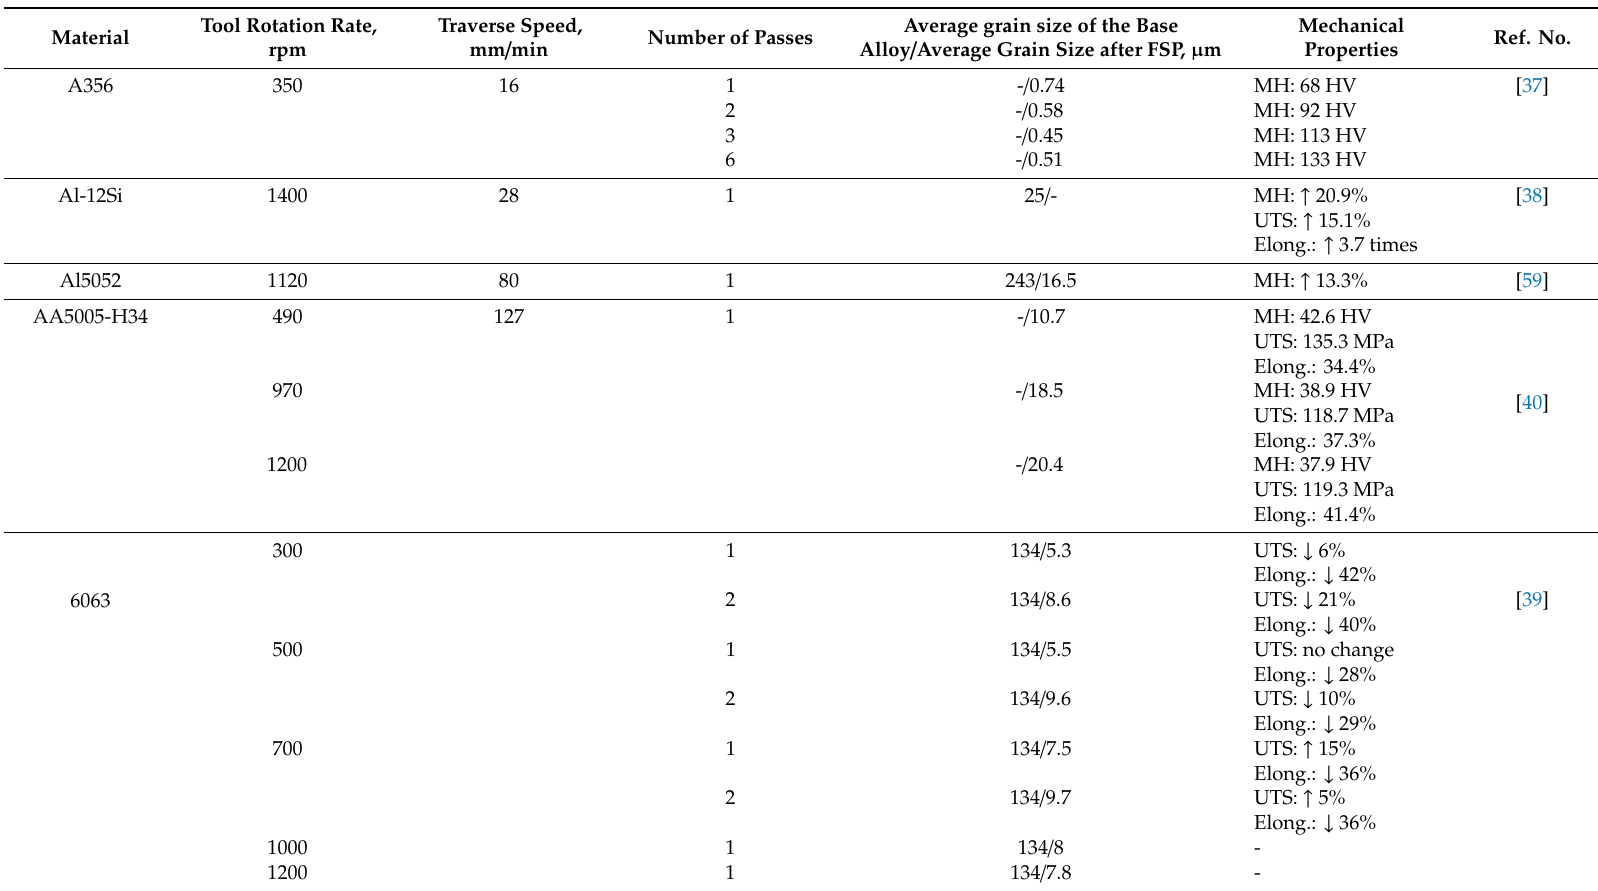
Table 1. Experimental data on FSP of aluminum